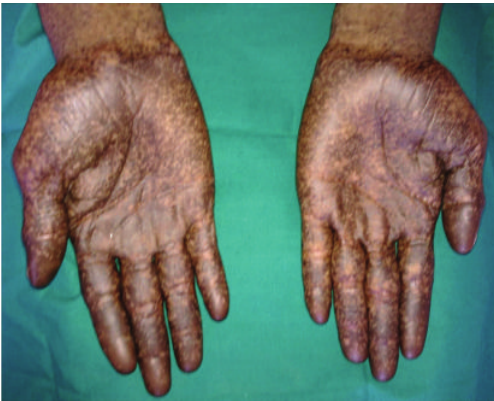
Figure 1: Photographs showing dark mottled pigmentation on the hands.